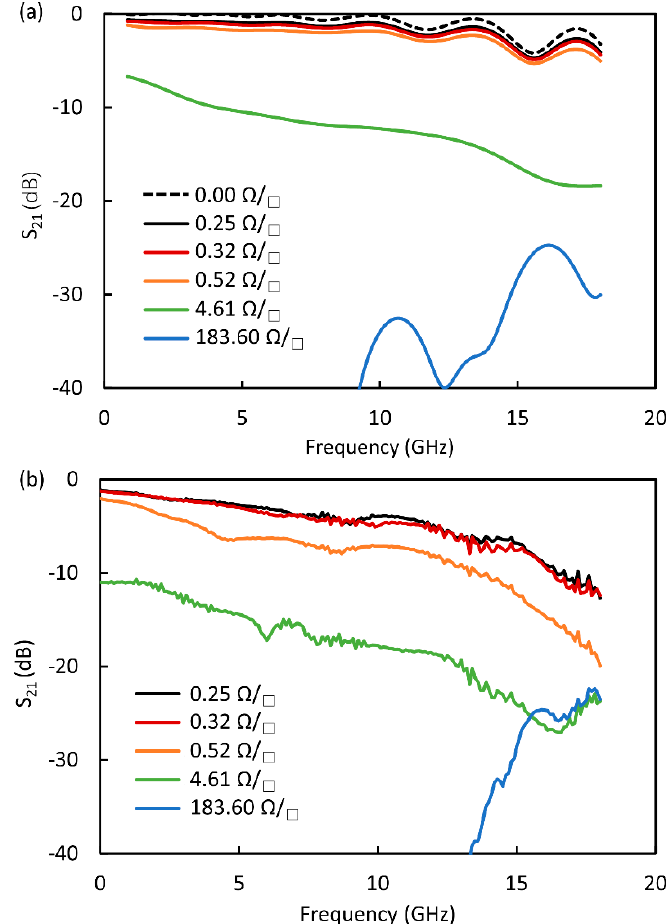
Figure 5. S 21 spectra at various sheet resistances: ( a ) simulation results; ( b ) experiment results.